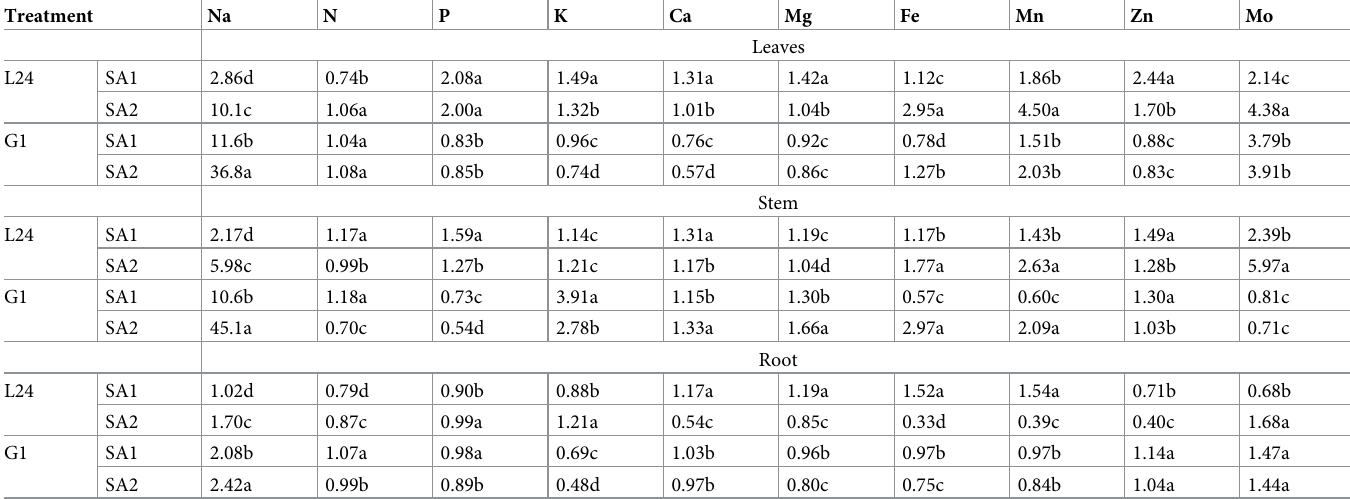
Table 5. The relative content of elements in leaves, stem and root of two cotton varieties under saline-alkaline stress. Treatment